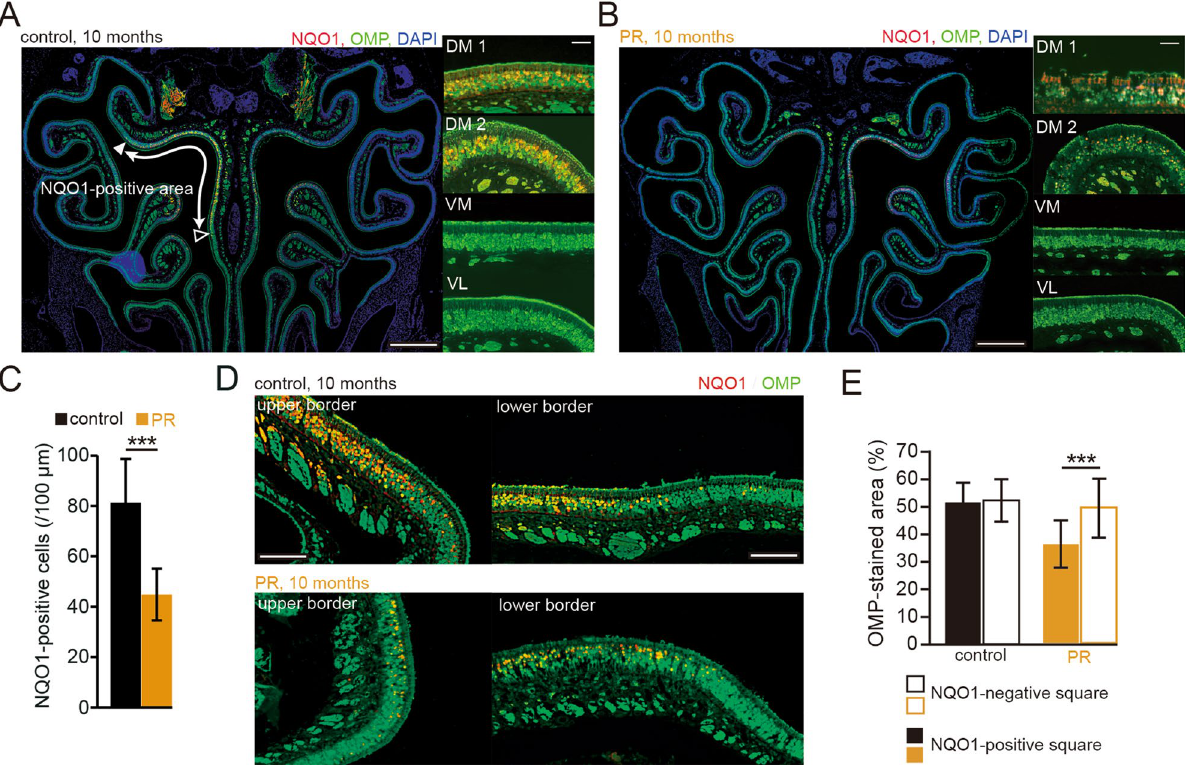
Figure 4. PR induces OE injury in zone 1. ( A , B ) Photomicrographs of representative coronal sections from control and PR mice. Low magnification images are shown on the left (red, anti-NQO1; green, anti-OMP; blue, DAPI), and high magnification images are shown on the right (red, anti-NQO1; green, anti-OMP). DM1 indicates the upper nasal septum in the dorsomedial area, and DM2 indicates the upper concha bullosa in the dorsomedial area. Closed triangle, upper border of the NQO1-positive area; open triangle, lower border of the NQO1-positive area. Scale 300 µm at low magnification, 50 µm at high magnification. ( C ) Comparison of NQO1-positive cells between control and PR mice. In PR mice, numbers of NQO1-positive cells were significantly lower than in control mice (***P < 0.001, Mann–Whitney test). ( D ) Photomicrographs of upper (closed triangle in A ) and lower borders (open triangle in A ) in control and PR mice (red, anti-NQO1; green, anti-OMP). Scale 50 µm. ( E ) Comparisons of the areas immunostained with OMP between the NQO1-positive and negative squares in control and PR mice. The OMP-stained area within the NQO1-positive square in the PR mice was significantly reduced compared with the NQO1-negative square (***P < 0.001, Mann–Whitney